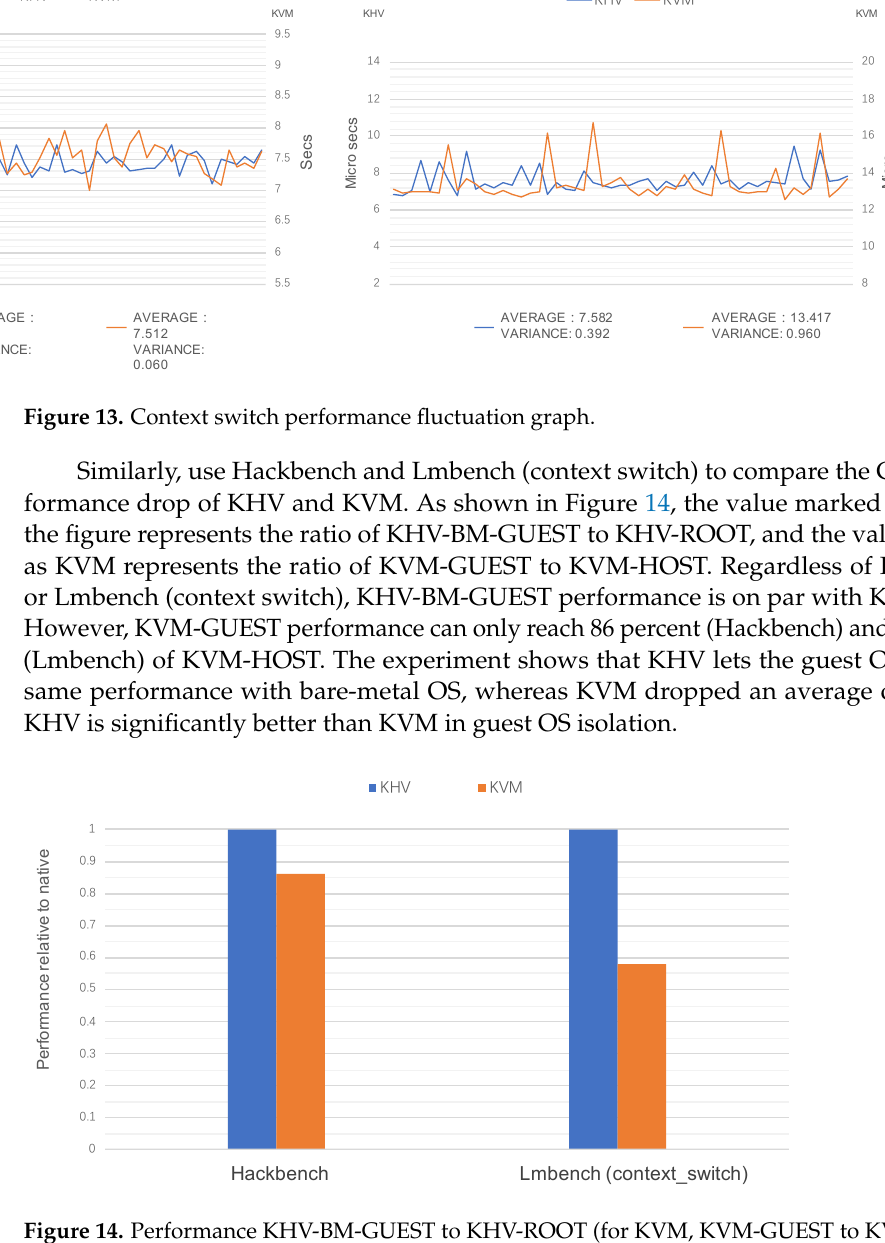
Figure 14. Performance KHV-BM-GUEST to KHV-ROOT (for KVM, KVM-GUEST to